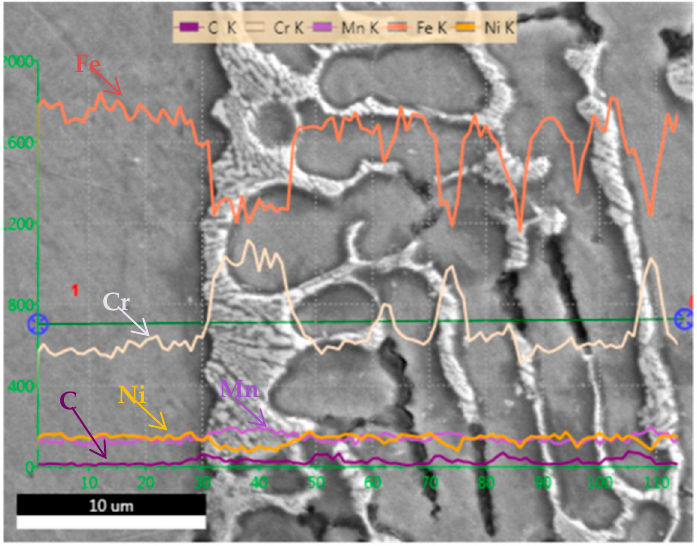
Figure 5. SEM-EDS analysis of PQ SS304.